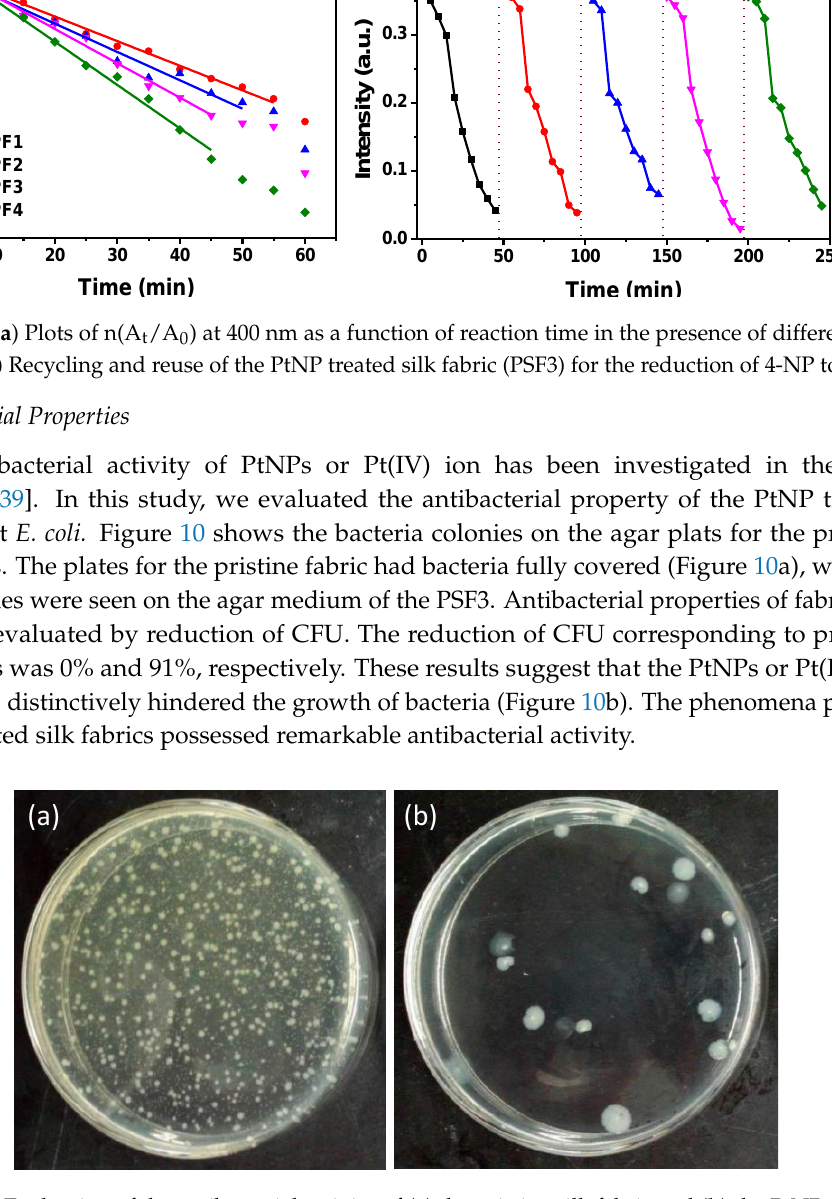
Figure 10. Evaluation of the antibacterial activity of ( a ) the pristine silk fabric and ( b ) the PtNP treated silk fabric (PSF3).